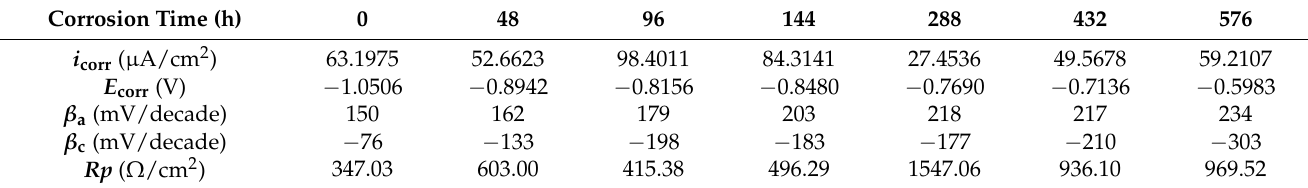
Figure 5. Potentiodynamic polarization curves ( a ) and corrosion potential ( b ) of 30CrMnSiA steel. Table 4. Electrochemical parameters calculated from potentiodynamic polarization curves.